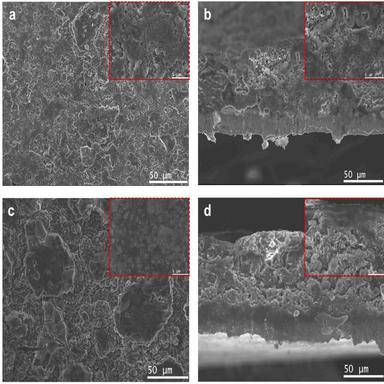
Field emission-SEM images of the MKAC-180 anode: (a) planes and (b) cross-sections before cycling, (c) planes and (d) cross-sections after 1000 cycles at 1.0 A⋅g− 1 .